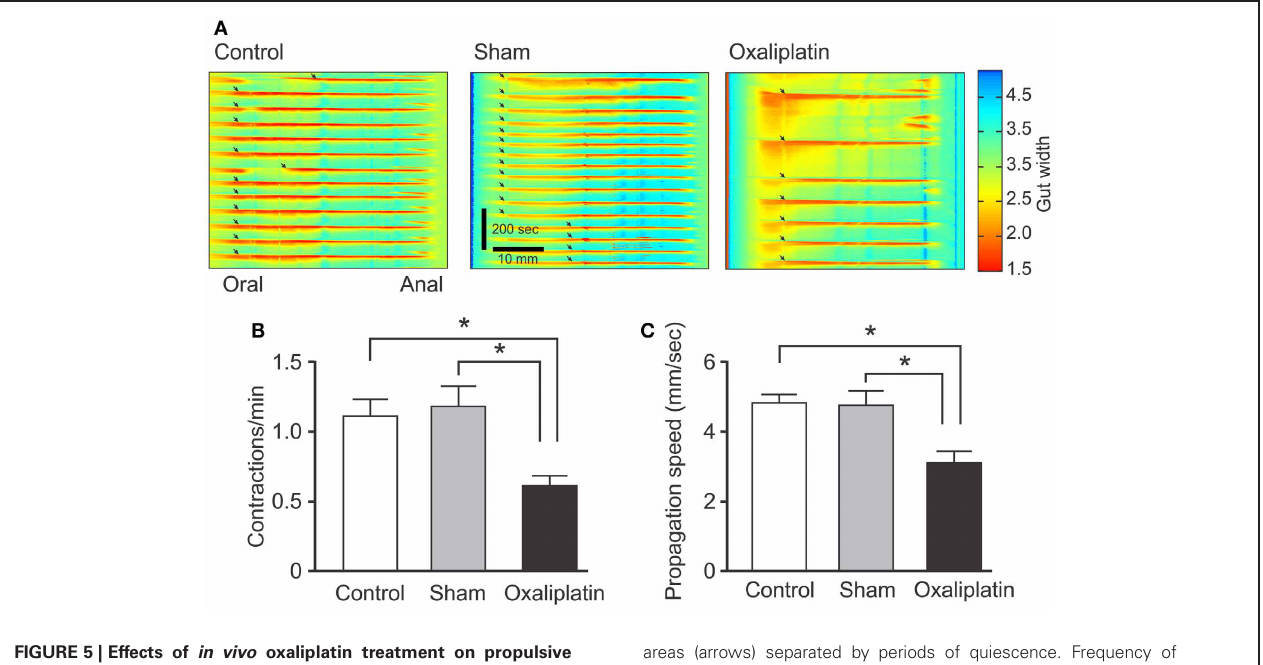
FIGURE 5 | Effects of in vivo oxaliplatin treatment on propulsive activity of the colon. Spatiotemporal maps of the colon (A) from control, Day 14 sham-treated, and Day 14 oxaliplatin-treated mice. Anally propagating contractions that begin at the oral end of the preparation and continue to the anal end can be readily seen as red